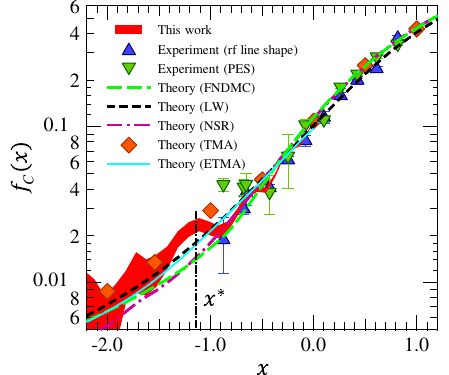
FIG. 8. Experimental and theoretical dimensionless internal energy density. The red curve indicates the experimental data of the present study in the superfluid state ( x > x (cid:4) ). The width indicates the total systematic error. The black square indicates the experimental data obtained using spin-balanced unitary Fermi gas [19], and the dotted green curve is an approximated curve based on pressure measurements of Ref. [18]. The light blue curve indicates the ETMA [31,32]. The open brown squares indicate data obtained by the QMC method [33]. The long dashed green curve was obtained by the FNDMC method [34]. The dash-dotted purple curve was obtained by the NSR theory [35]. The dashed black curve was obtained by the LW approach [36].